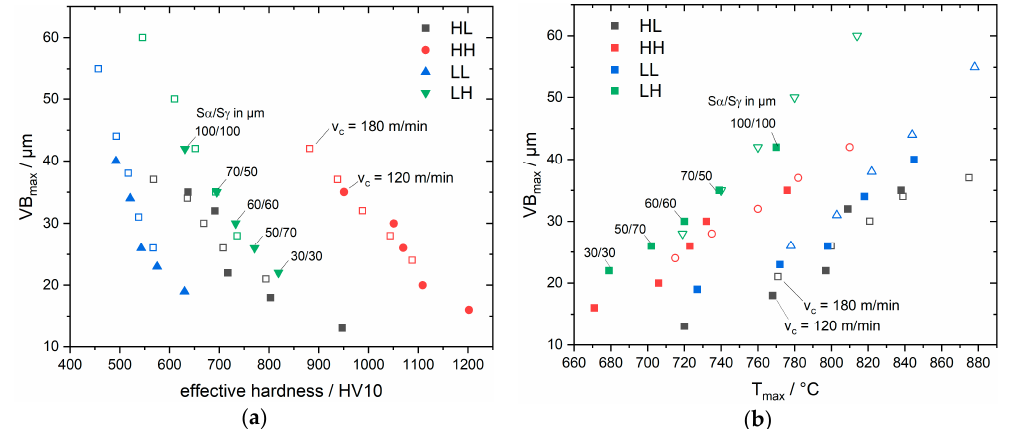
Figure 11. Maximum flank wear VB max as a function of ( a ) effective hardness and ( b ) maximum temperature T max for different cutting edge roundings S α /S γ and different cutting speeds v c = 120 temperature T max for di ff erent cutting edge roundings S α / S γ and di ff erent cutting speeds v c = 120 m / min m/min (filled symbols) and v c = 180 m/min (unfilled symbols). (filled symbols) and v c = 180 m / min (unfilled